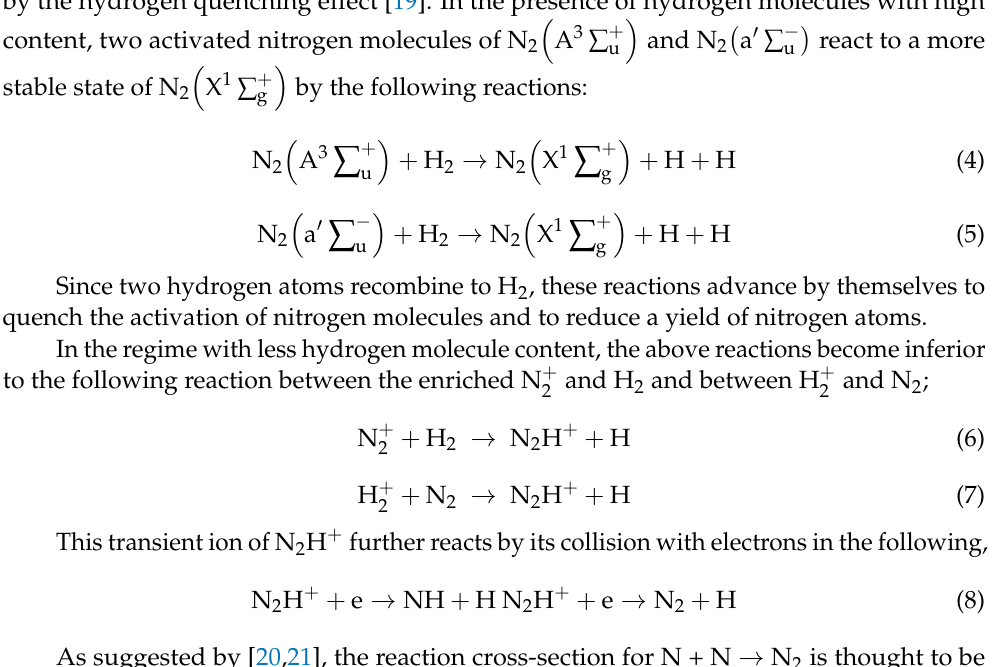
Figure 7. Variation in the peak intensity ratio for NH-radicals to N (cid:2870)(cid:2878) ions with the increase in hydrogen gas content.